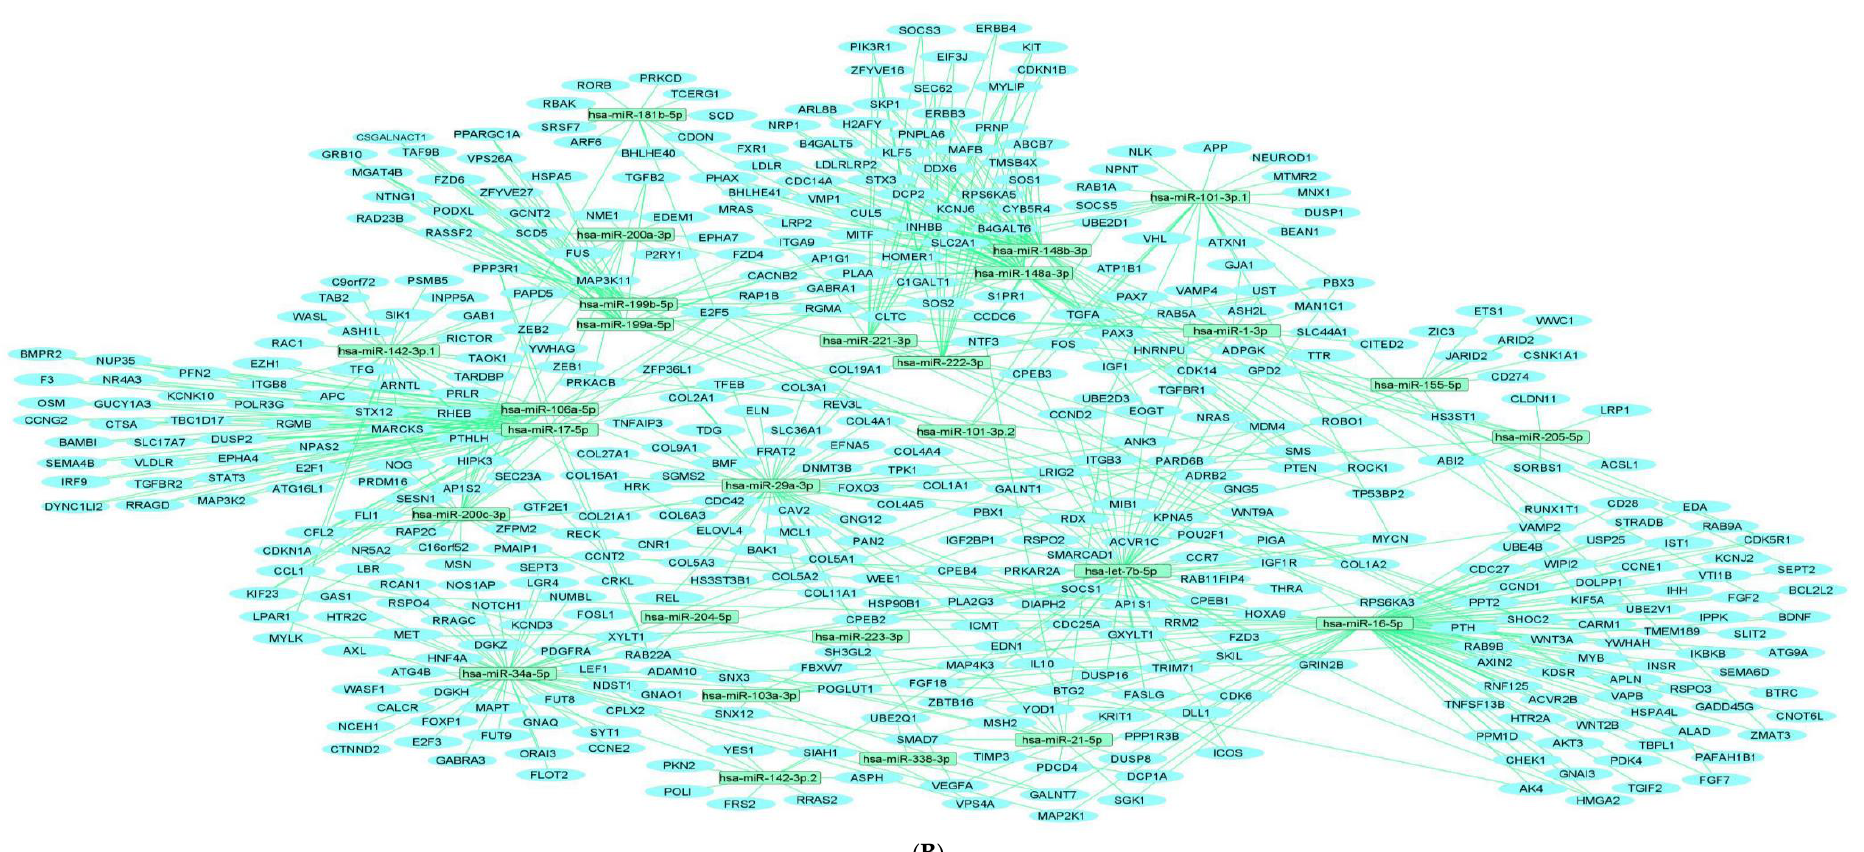
Figure 1. Upregulated human microRNA networks in diabetes: ( A ) Human microRNA – microRNA network: Human miRNA – miRNA interaction network with 106 nodes and 11,130 edges. The networks were constructed using Cytoscape 3.9.1 [84]. ( B ) Human microRNA – gene target network: Architecture of networks of upregulated miRNAs implicated in diabetes in humans showing interaction network of functionally enriched miRNAs with their targets, with 484 nodes and 691 edges. The networks were constructed using Cytoscape 3.9.1 [84]. Using Mienturnet [85], the miRNA – target interactions were identified by TargetScan [86], and the functionally enriched miRNAs were generated using the KEGG database [87].